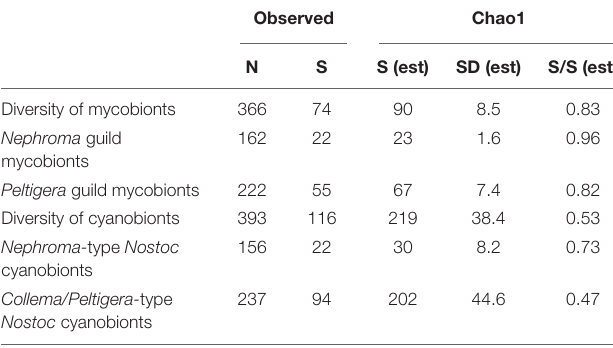
TABLE 1 | Diversity